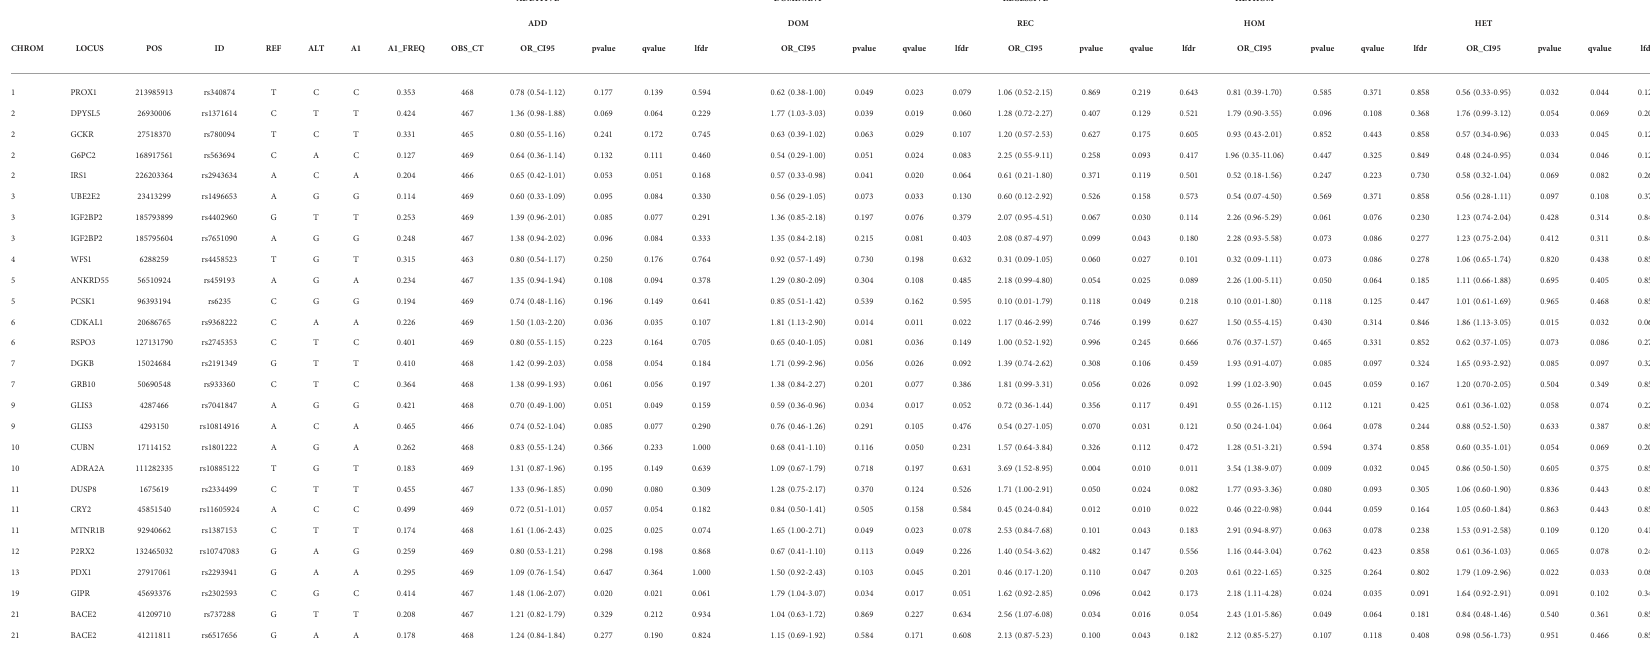
Table that summarizes the most relevant results of the analysis of SNPs + Group models in Hispanic (HIS) ethnicity. ADD, Additive model; DOM, dominant model; REC, recessive model; HETHOM, heterozygous-homozygous model; CHROM, Chromosome code; LOCUS, Locus/Gene; POS, Base-pair coordinate [GRCh38]; ID, Variant ID; REF, Reference allele; ALT, Alternate allele; A1, Counted allele in logistic regression; A1_FREQ, minor allele frequency; OBS_CT, Number of samples in the regression; OR_CI95, odds ratio with 95% con fi dence